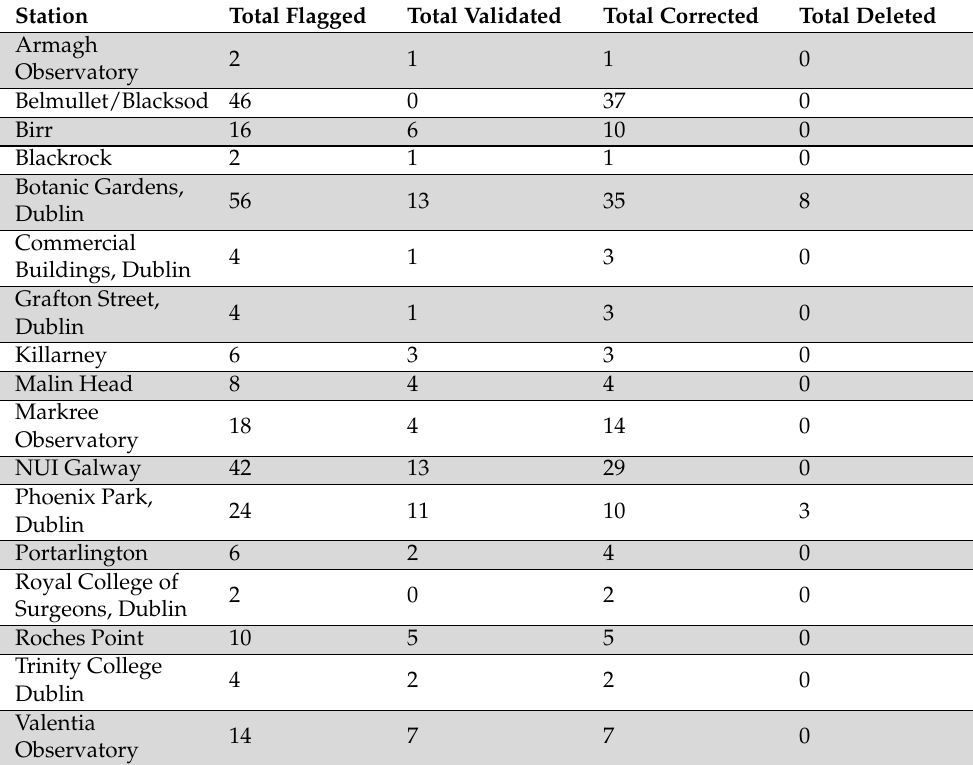
Table A5. Total of flagged daily MAX and MIN data, which failed the quality control test flag 5 per station.